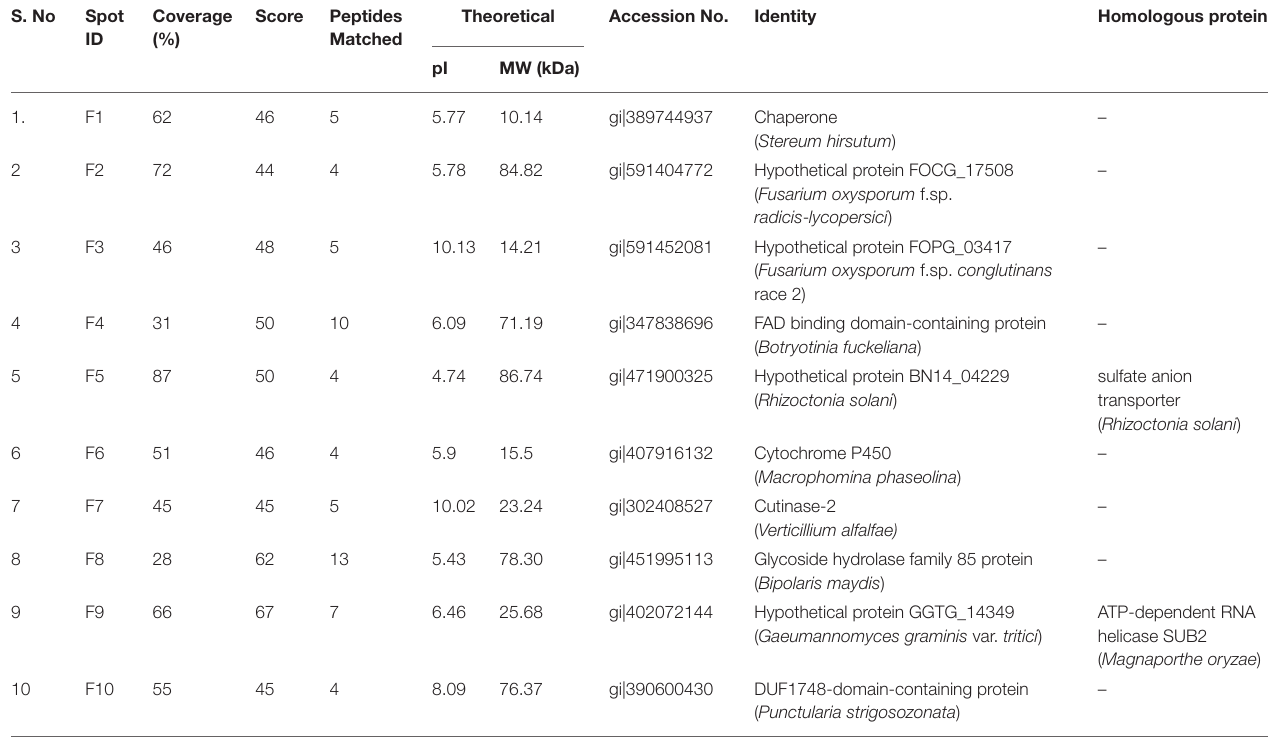
TABLE 4 | List of expressed differential proteins in Fusarium isolates identified through 2-DE- MALDI-TOF. S. No Spot Coverage Score Peptides Theoretical Accession No. Identity Homologous ID (%) Matched